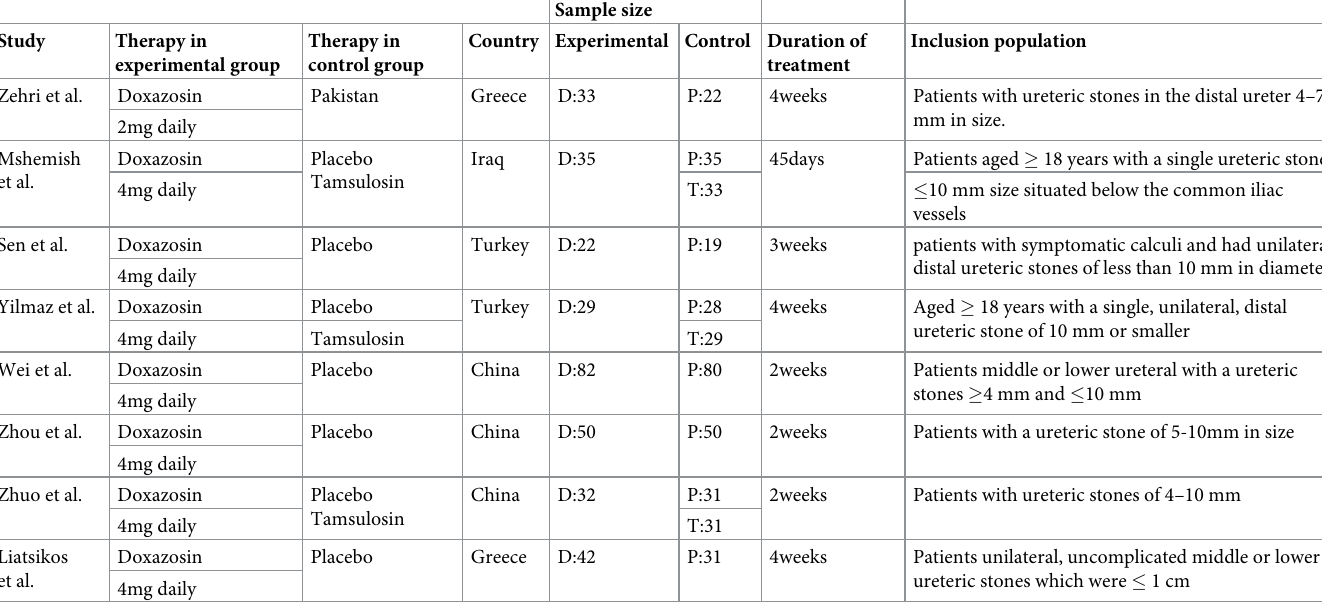
Table 1. Study and patient